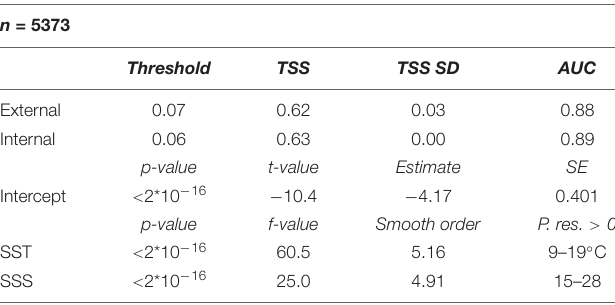
TABLE 1 | Generalized additive mixed model